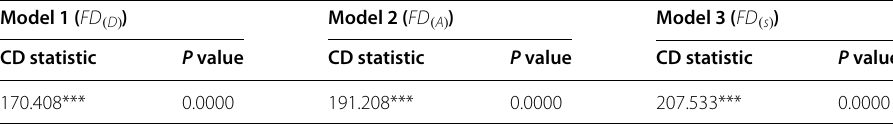
H 0 errors are weakly cross-sectionally dependent. CD ∼ N ( 0,1 )